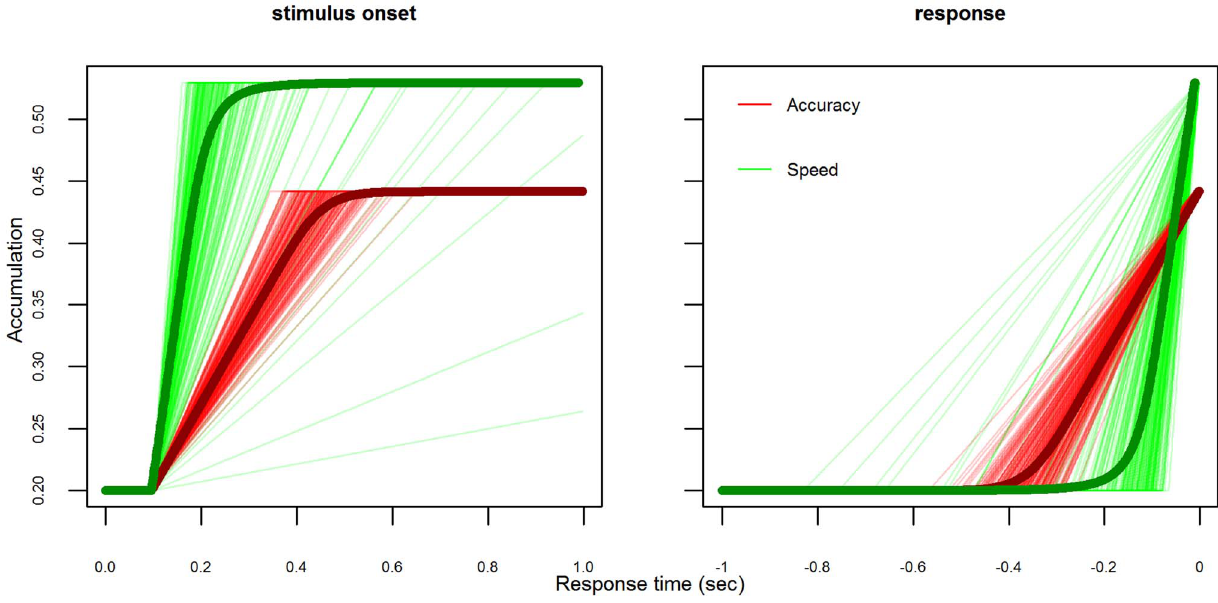
Figure 3. Sample accumulation trajectories, for monkey Q, for the accumulator corresponding to a neuron with a target in its receptive field. To correspond with neural data, only trajectories corresponding to correct decisions are displayed. Mean trajectories overlaid as heavy lines. Left panel displays paths aligned on stimulus onset. Right panel displays paths aligned on response. Only speed and accuracy emphasis conditions plotted due to high similarity between neutral and speed emphasis.